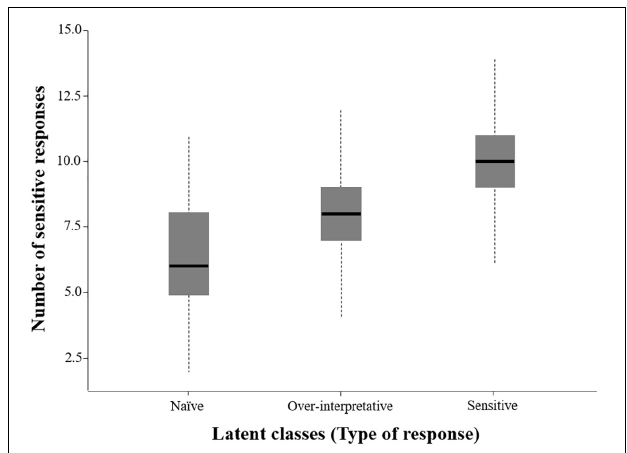
FIGURE 1 | Distribution of latent classes in the population of children from elementary school.